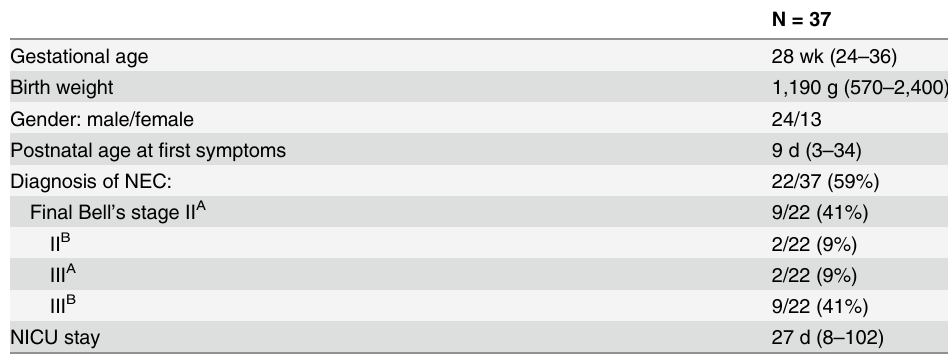
Table 1. Characteristics of included patients.